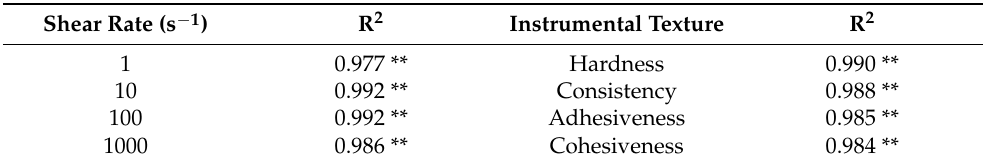
Table 4. Correlation between creaminess and instrumental texture parameters/viscosities at different shear rates. Shear Rate (s − 1 ) R 2 Instrumental Texture R 2 1 0.977 ** Hardness 0.990 ** 10 0.992 ** Consistency 0.988 ** 100 0.992 ** Adhesiveness 0.985 ** 1000 0.986 ** Cohesiveness 0.984 ** ** indicates significant difference at p <